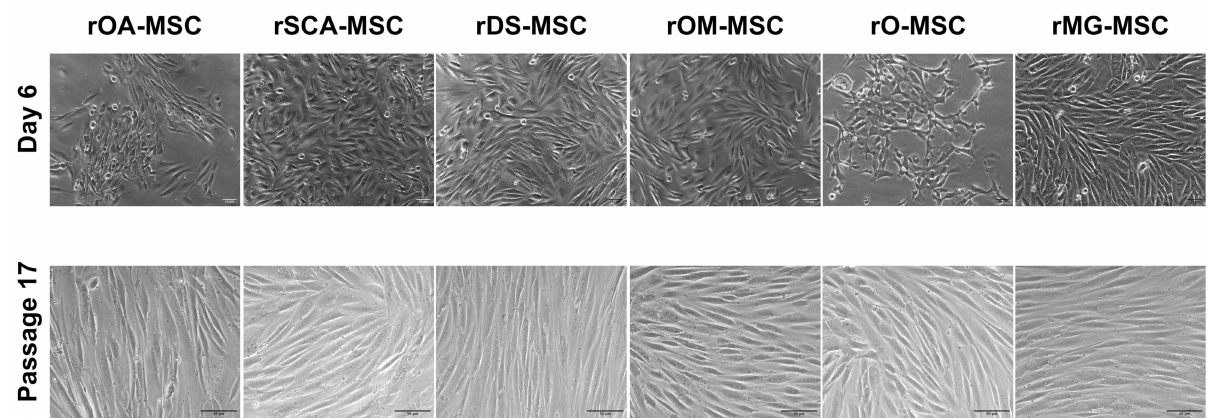
Figure 1. Phase-contrast images of different rabbit rMSC lines at 6 days of culture of Passage 0 (upper panels; × 100 magnification) and Passage 17 (lower panels; × 200 magnification). Bars = 50 µ m.